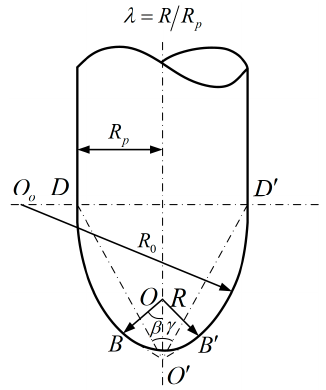
Figure 5. Hemispherical radius of the head.